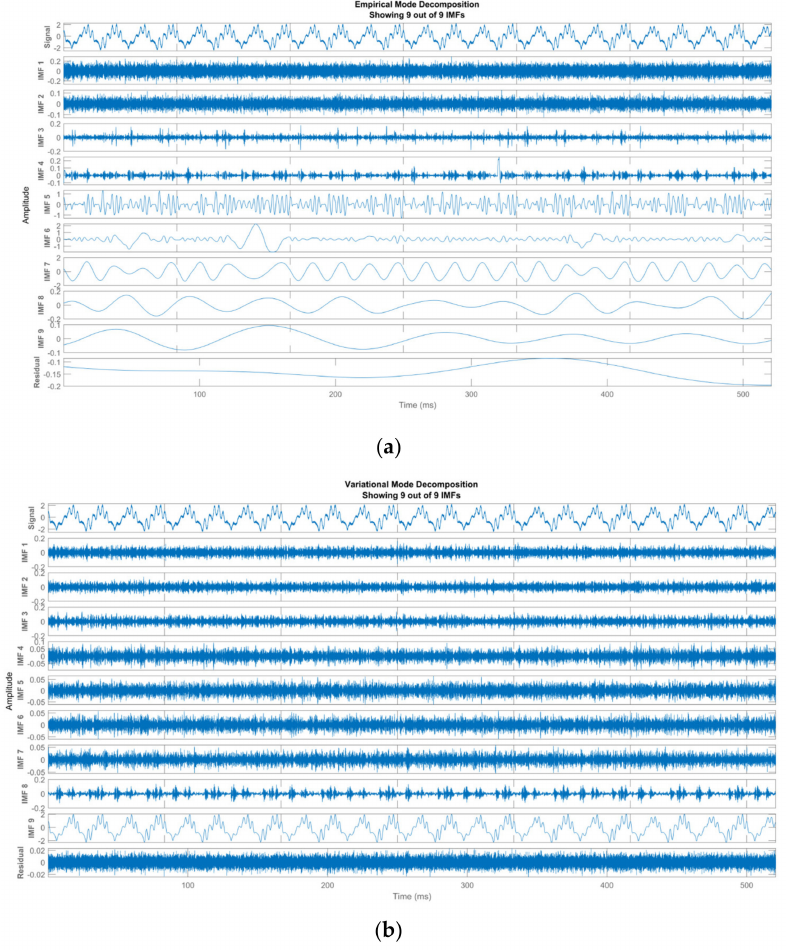
Figure 10. EMD ( a ) and VMD ( b ) decomposition of natural ester liquid current signal under VDE electrode arrangement (d = 2